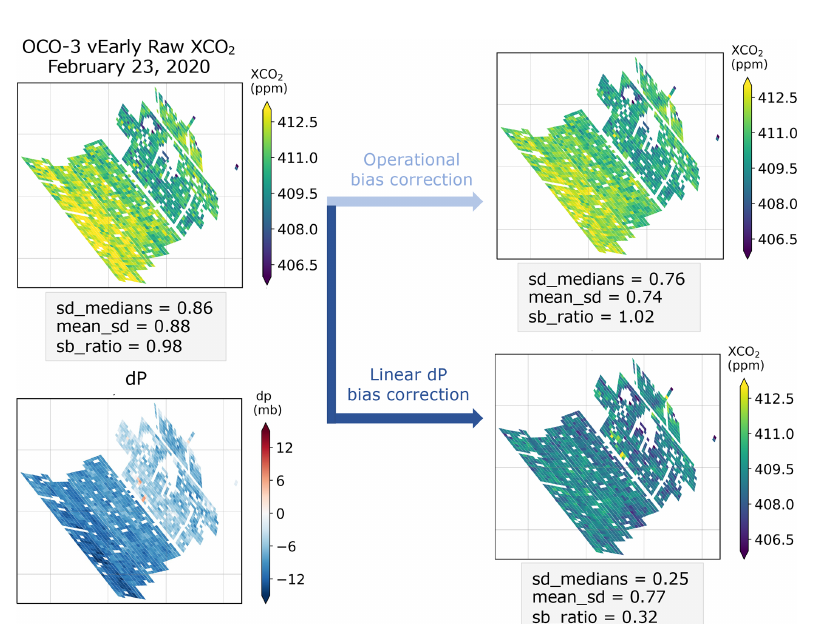
Figure 17. sd_median versus each of our tested parameters.